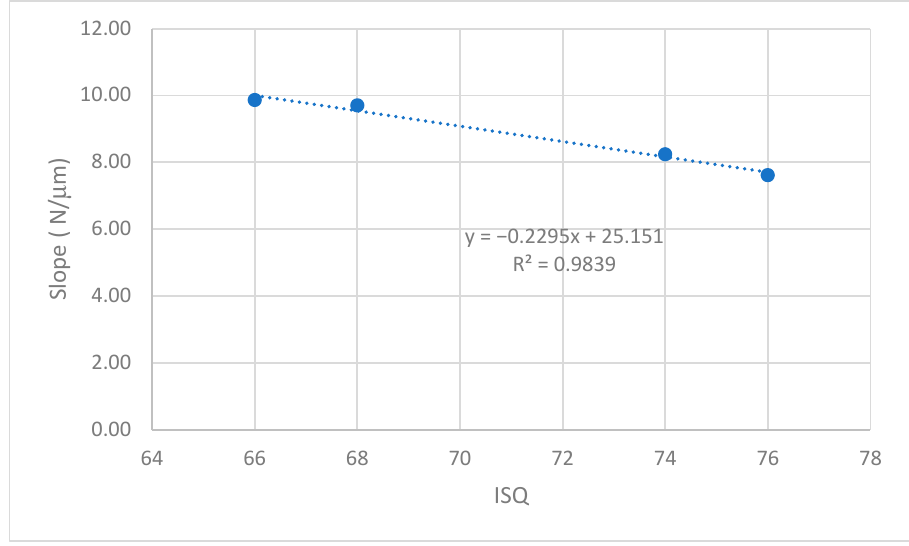
Figure 13. Relationship between the slope of the linear equation (micromovement-applied load) versus ISQ.